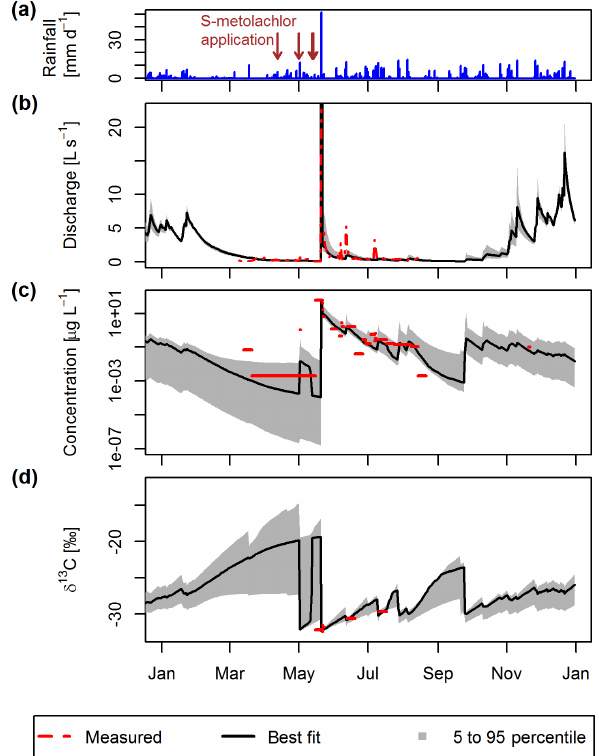
Figure 4. Daily precipitation (a) , and measured (red lines) and mod- elled time series for discharge (b) , S-metolachlor concentrations ( c ; note the log-scaling), and δ 13 C values (d) at the catchment outlet in 2012. The black line indicates the results of the calibration run with the best fit in terms of N Q / 6, N C , and N δ 13 . Shaded areas show the C range between the 5th and 95th percentiles of all simulation results. Brown arrows in (a) indicate the dates of pesticide